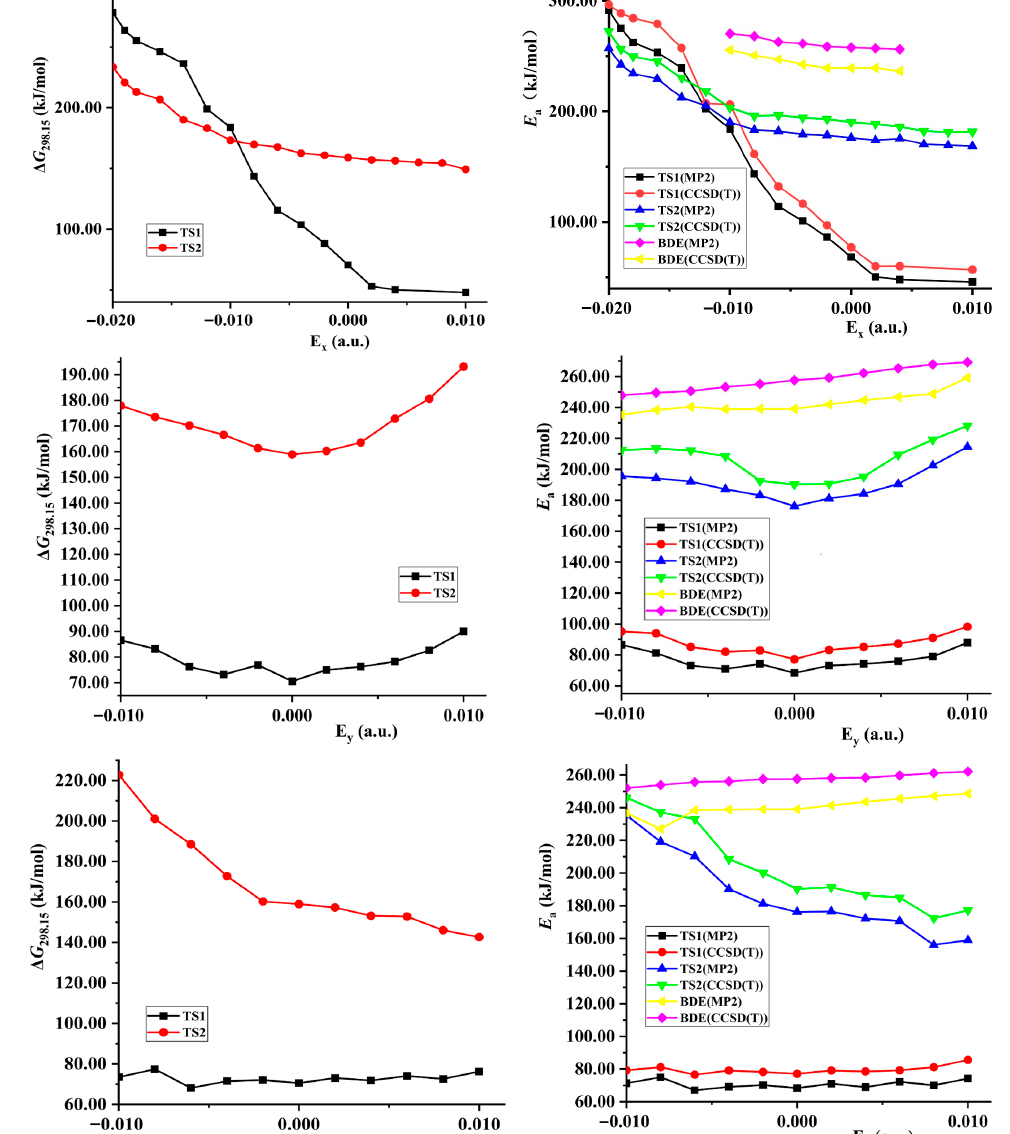
Figure 3. Gibbs energies ( ∆ G ), barriers ( E a ), or N − NO 2 BDEs versus field strengths along the different field orientations (E x, E y and E z ).